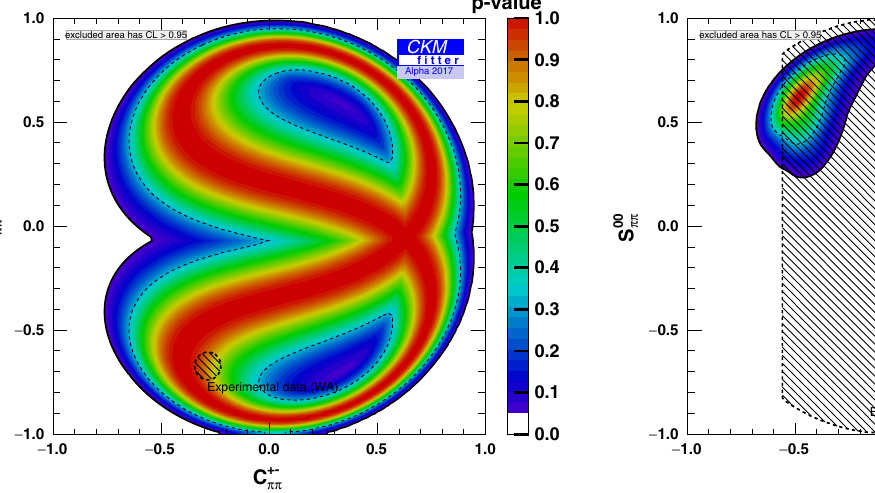
Fig. 27 Two-dimensional SU ( 2 ) isospin constraint on the CP asym- metries C ππ and S ππ for the B 0 → π + π − decay ( left ) and the B 0 → π 0 π 0 decay ( right ). The direct measurement, not included in the fit, is indicated by the shaded area. Only the direct CP asymme-